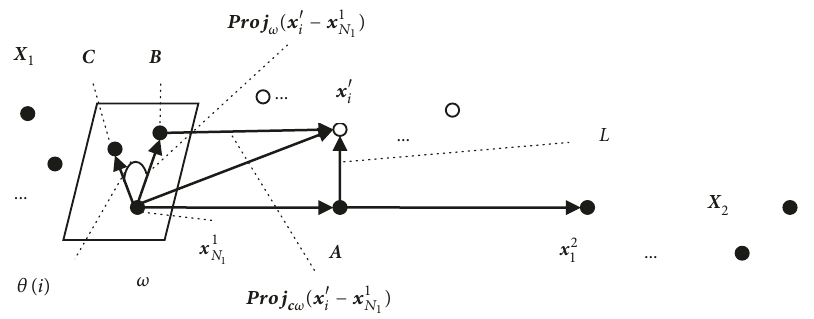
Figure 2: The analysis of the optimized